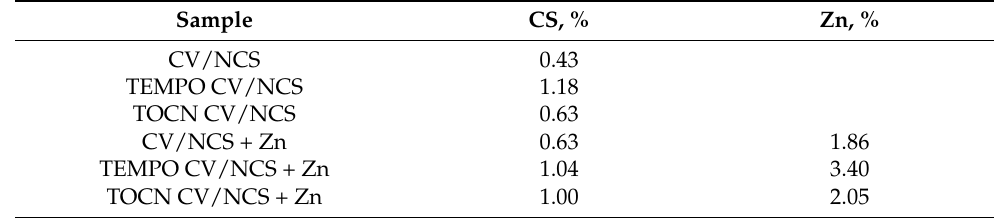
Table 3. The chitosan and zinc content in the NCS and NCS + Zn functionalized viscose fabrics